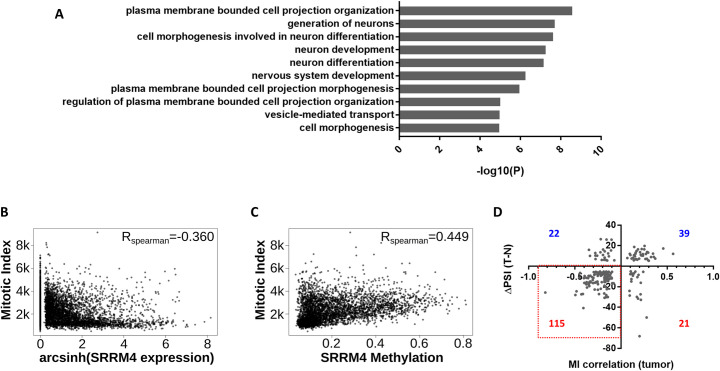
SRRM4 correlates with MI in tumors.(A) GO term enrichment of genes with down-regulated SRRM4 target exons in tumors from TCGA. The top 10 most significantly enriched terms are shown (GO biological process complete; 2-sided hypergeometric test with Bonferroni step down correction). (B) Spearman correlation of MI gene signature with SRRM4 expression across TCGA tumor samples. Each point represents 1 tumor sample. (C) Spearman correlation of MI gene signature with SRRM4 promoter methylation (beta value) across TCGA tumor samples. Each point represents 1 tumor sample. (D) x-Axis: Spearman correlation coefficient (RSpearman) between MI gene signature and exon PSI for each SRRM4 target exon in tumors; y-axis: ΔPSI (Tumor − Normal). The number of exons in each quadrant is indicated (red indicates negative ΔPSI, and blue indicates positive ΔPSI). Each point represents 1 exon from 1 tissue. Only exons with |ΔPSI| > 5 and q < 0.01 are shown. Data underlying Fig 4A can be found in S5 Data. Data underlying Fig 4B–4D can be found in S1 Data figures. GO, gene ontology; MI, mitotic index; PSI, percent spliced in; SRRM4, Serine/Arginine Repetitive Matrix 4; TCGA, The Cancer Genome Atlas.